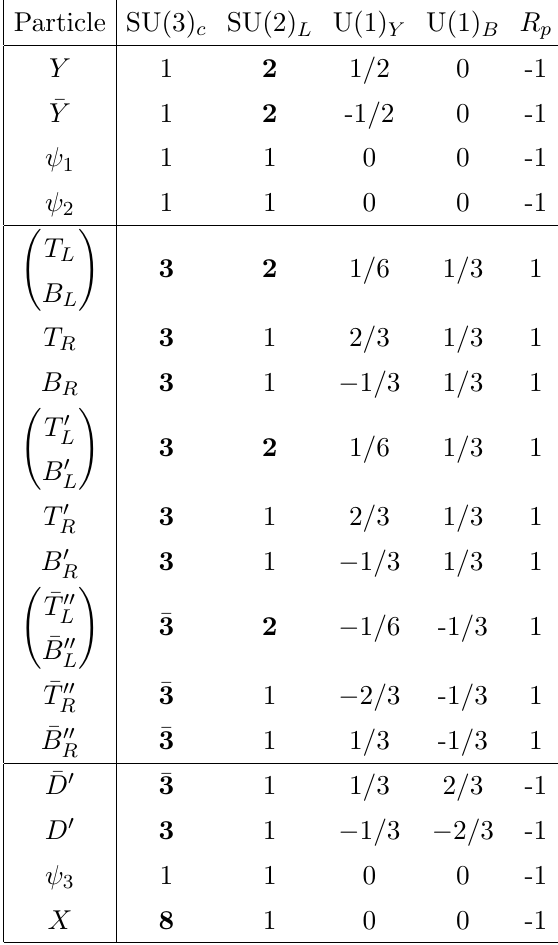
Table 7 . Fermionic Particle Content (Mass